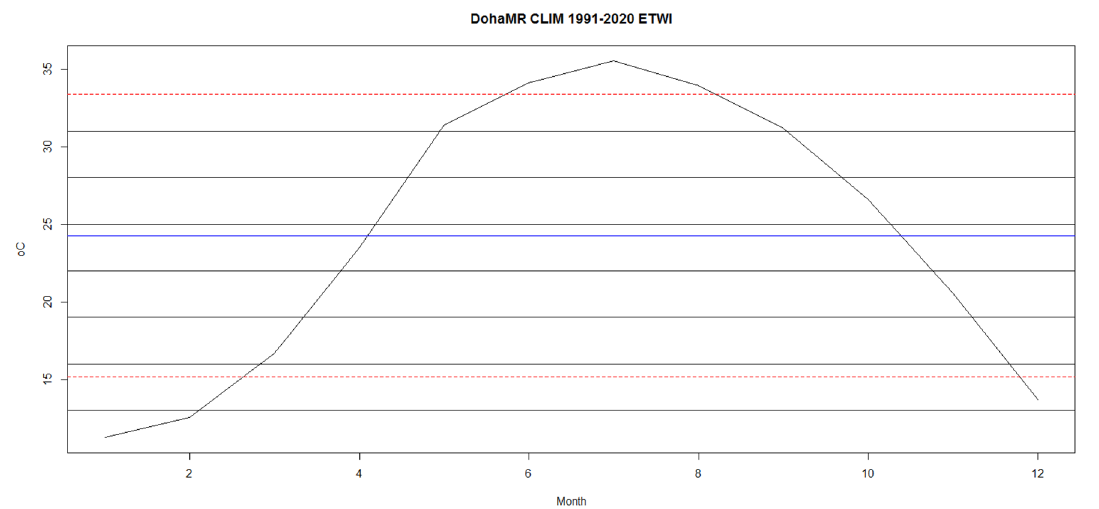
average and the red dashed line is the standard deviation-based interval, and the solid lines are the thresholds established in the lit- erature